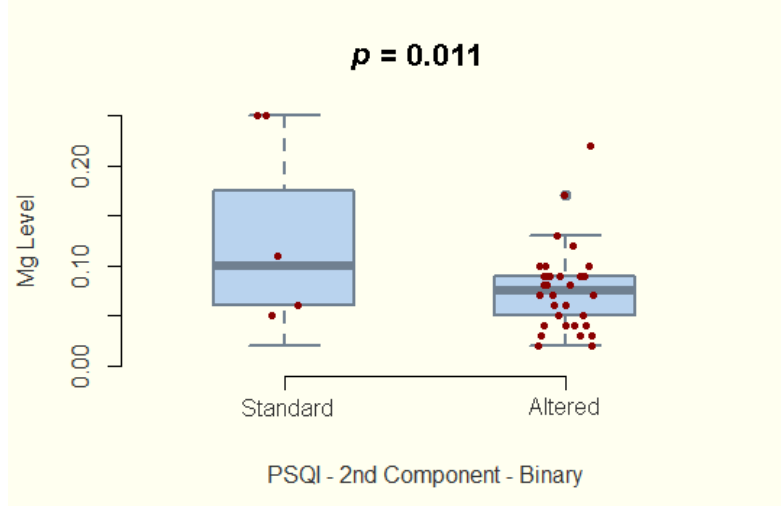
Figure 4. Evaluating the correlation between hair magnesium concentration and sleep latency (component 2 of the PSQI score) among IBD patients.